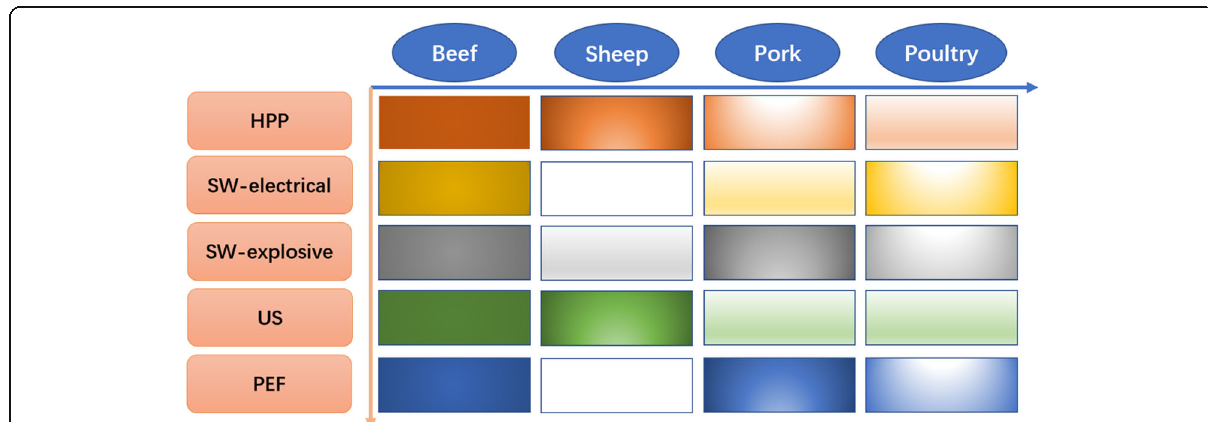
Fig. 8 The investigative focus between emerging physical interventions and different species (Bhat et al. 2018; Warner et al. 2017, with modification). The deeper color of the rectangle is, the wider investigation of the emerging physical intervention is. The white rectangle represents negligible